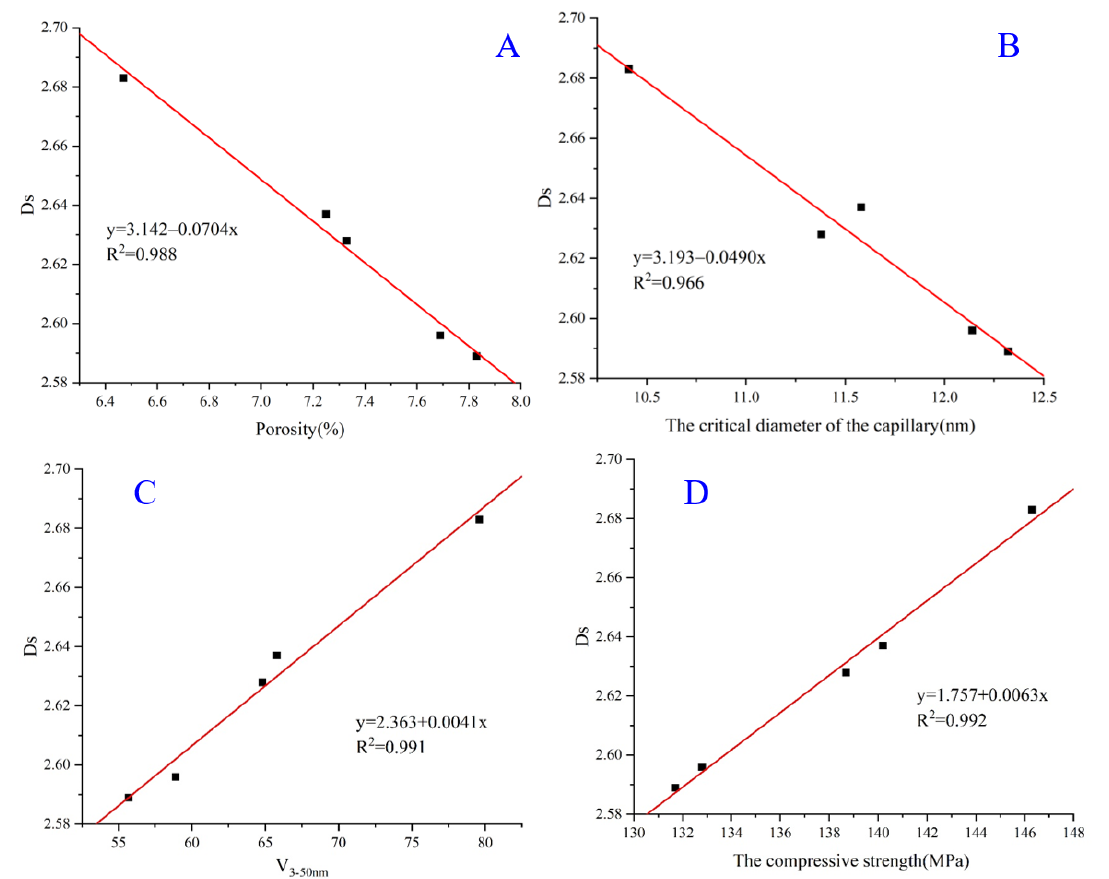
Figure 13. Relationship between the Ds and the ( A ) porosity, ( B ) CDC, ( C ) V 3–20 nm , and ( D ) compressive strength of the UHPC.